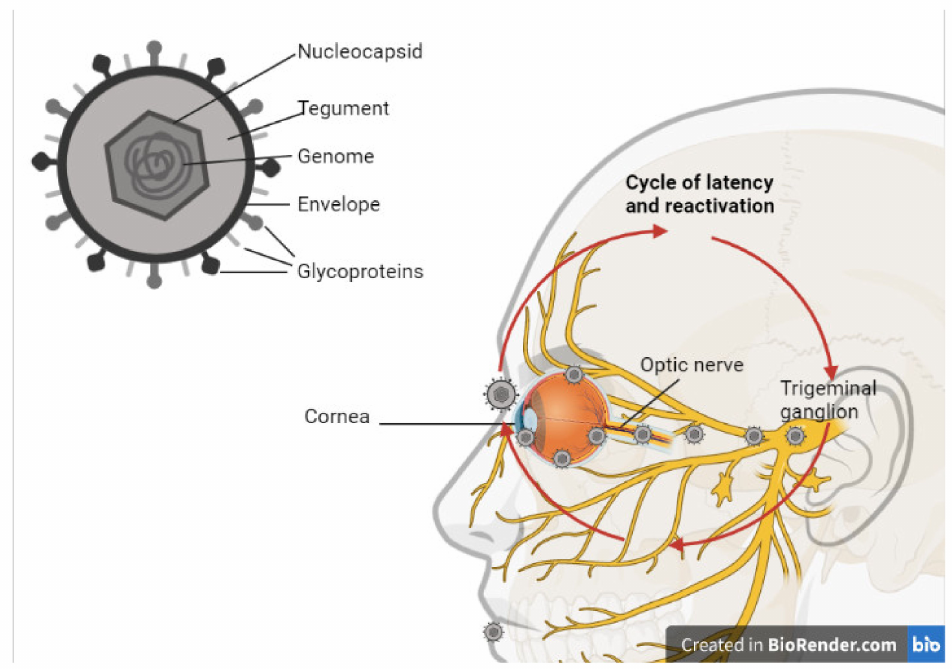
Figure 2. Schematic illustration of HSV-1 virion and the cycle of latency and infection. Created with BioRender.com (https://biorender.com/, accessed on 22 June